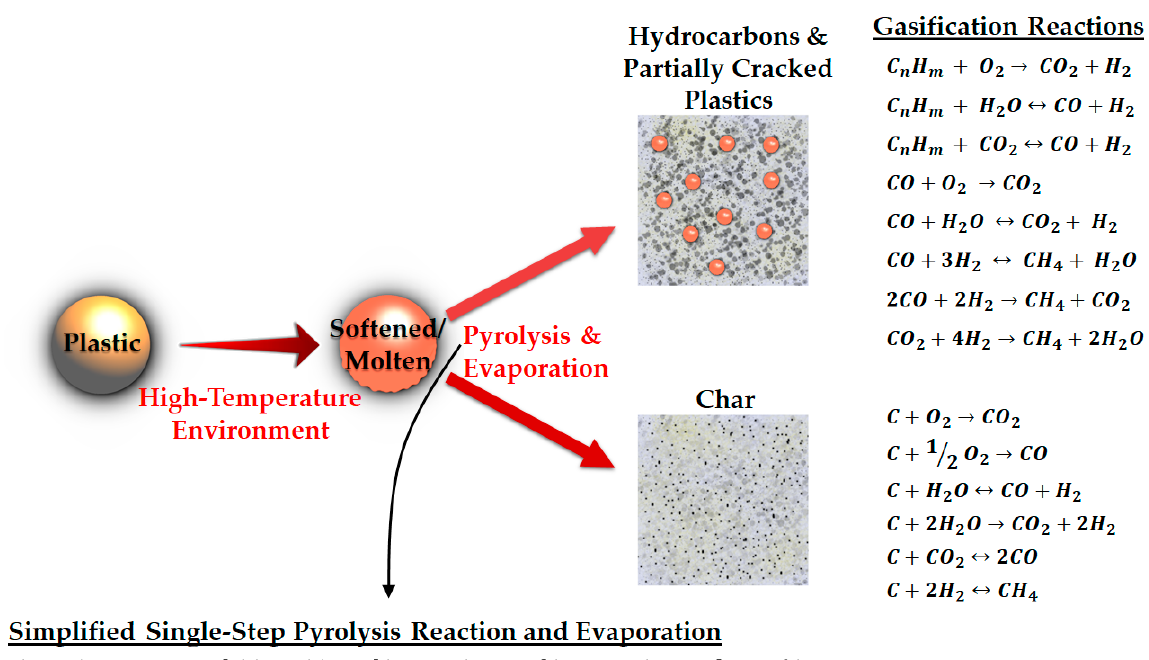
Figure 4. An overview of the plastic gasification process and the reactions taking place (the equations are taken from [20,22–25]). The separation of the hydrocarbons/partially cracked plastics and char is for the sake of illustration. Otherwise, they are present simultaneously in the reactor.